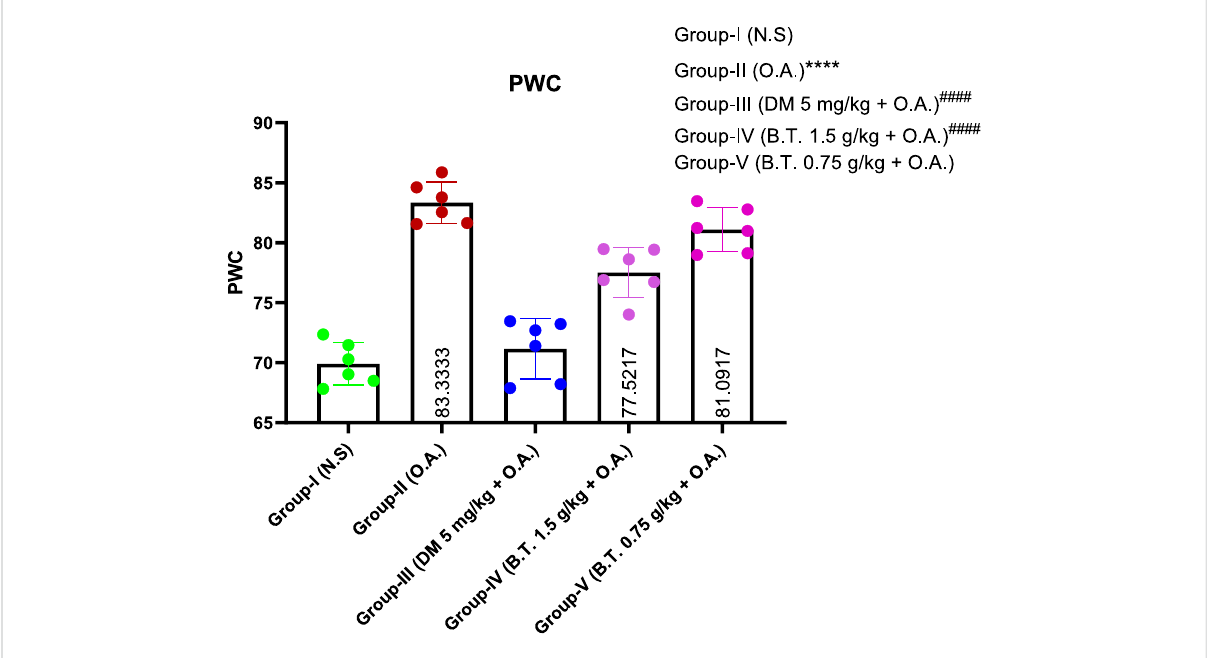
FIGURE 10 EffectofB.T.(1.5 g/kgB.W.)onthepulmonarywatercontent.EffectofB.T.(1.5 g/kgB.W.)onthepulmonarywatercontent.GroupIIreportedan elevated level of pulmonary oedema which was recti fi ed in the treatment groups III and IV. Comparisons between groups were performed using one-way ANOVA (Turkey ’ s multiple comparison tests) to compare the mean values of each group with each other. ( *p < 0.05, *** p < 0.01, and **** p < 0.001 is signi fi cantly different from group I; ### p < 0.01 and #### p < 0.001 are signi fi cantly different from group